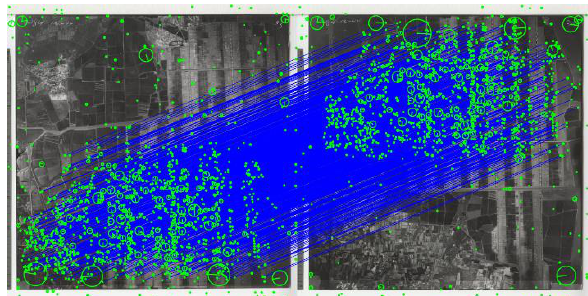
Figure 5. Example of removing outliers by